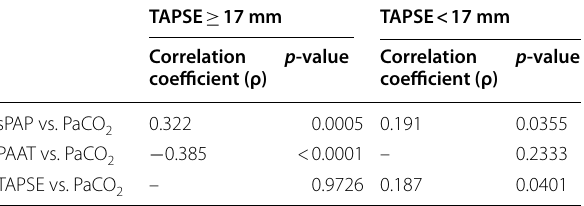
Table 3 Correlations between echocardiographic parameters and arterial partial pressure of carbon dioxide (PaCO with preserved and depressed RV systolic